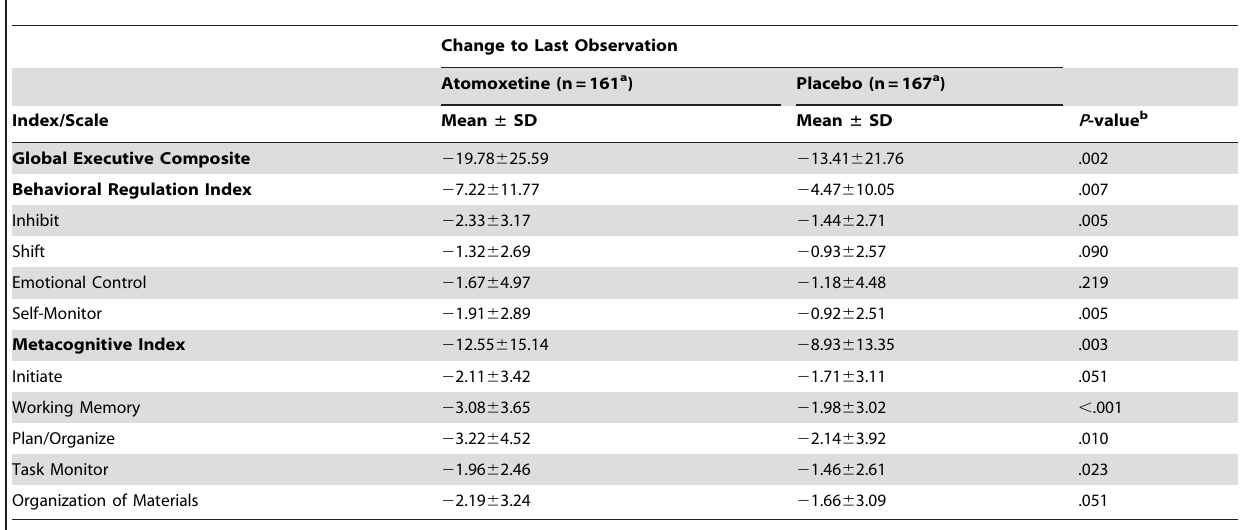
Table 3. BRIEF-A Mean Change from Baseline to Last Observation for All Randomized Patients.